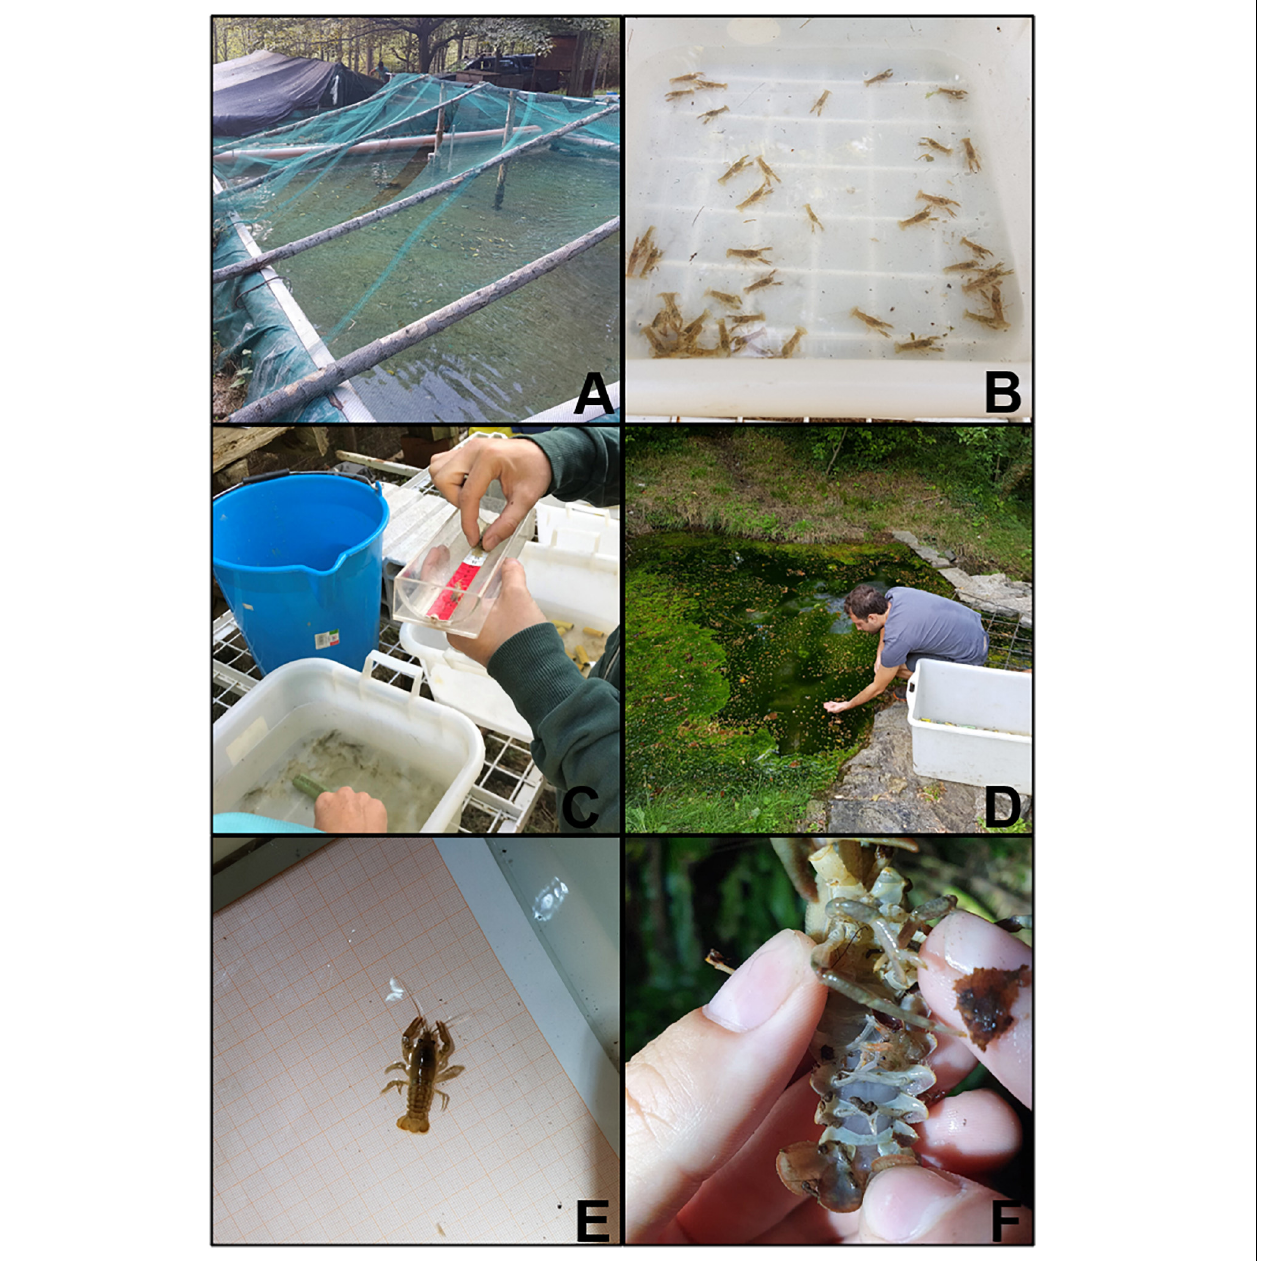
FIGURE 3 | Different steps and structures of the white-clawed crayfish reintroduction action. (A) The breeding facility of the ERSAF organization. (B) 3-month-old white-clawed crayfish ready for the release. (C) Measurement of the 3-month-old white-clawed crayfish. (D) Introduction of the white-clawed crayfish in September 2019. (E) Grown reintroduced white-clawed crayfish female in June 2019. (F) The finding of a reintroduced female in May 2020 with a newly hatched white-clawed crayfish still attached to the pleopods. Written informed consent was obtained from the person depicted in picture (D) for the publication of any potentially identifiable images or data included in this